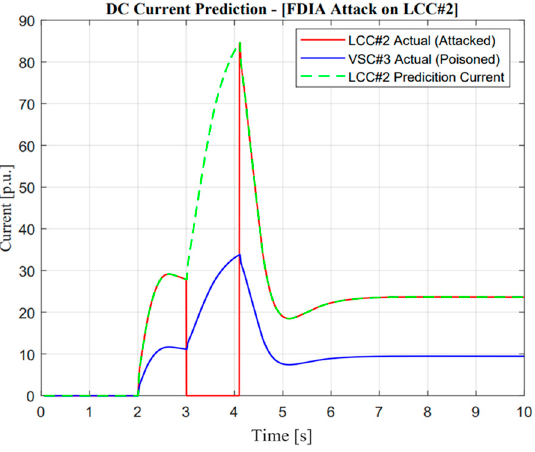
Figure 17. DC current prediction in false data injection attack operation.